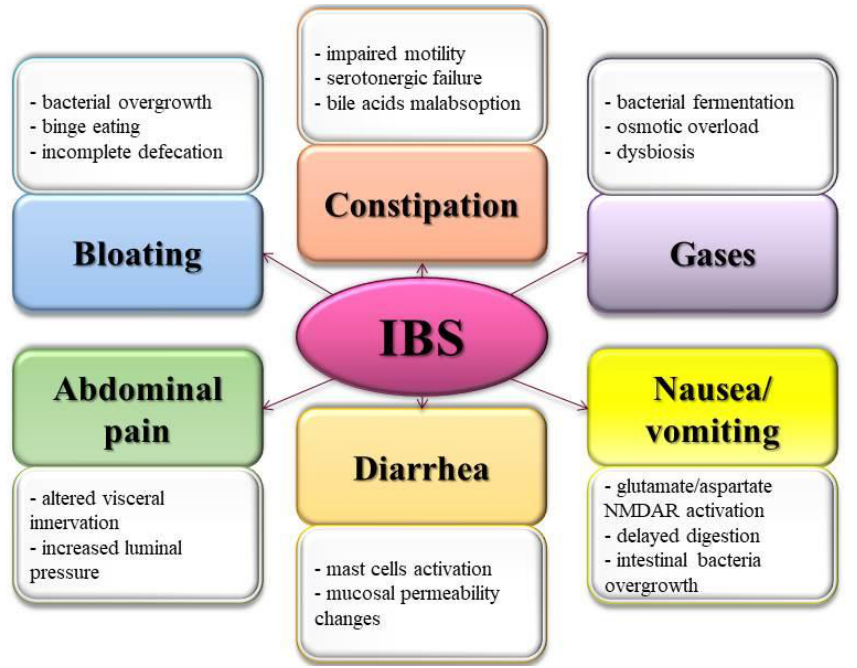
Figure 1. Pathological mechanisms of the main IBS symptomatology (according to ROME IV Diagnostic Criteria for functional gastrointestinal disorders) (NMDAR: NMDA receptor) [10,20 – 27].